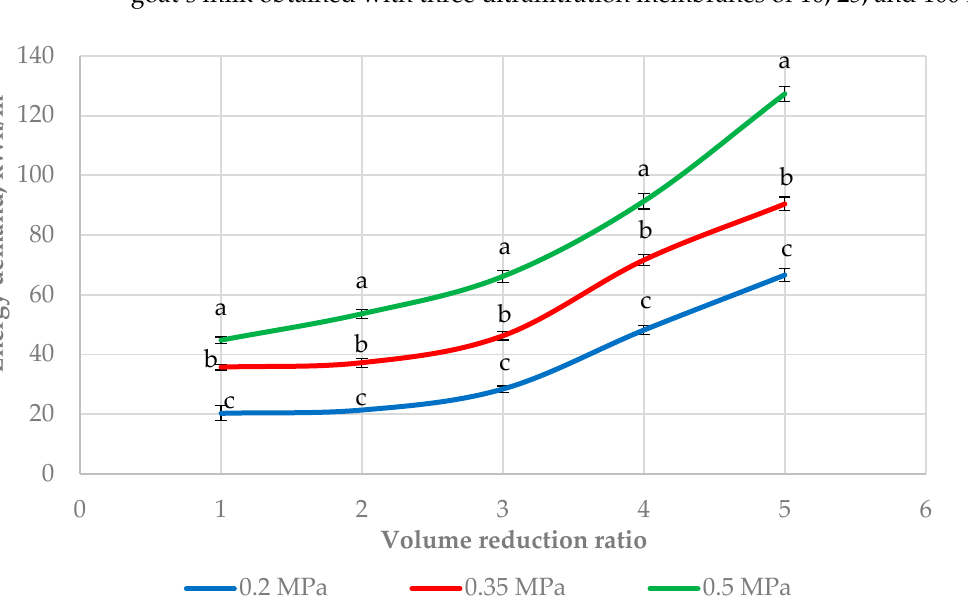
Figure 2. Effect of volume reduction ratio on the energy demand during ultrafiltration of sweet buttermilk. Different lowercase letters (a, b, c) show a significant difference between the energy demand at 0.2, 0.35, and 0.5 MPa ( p < 0.05).